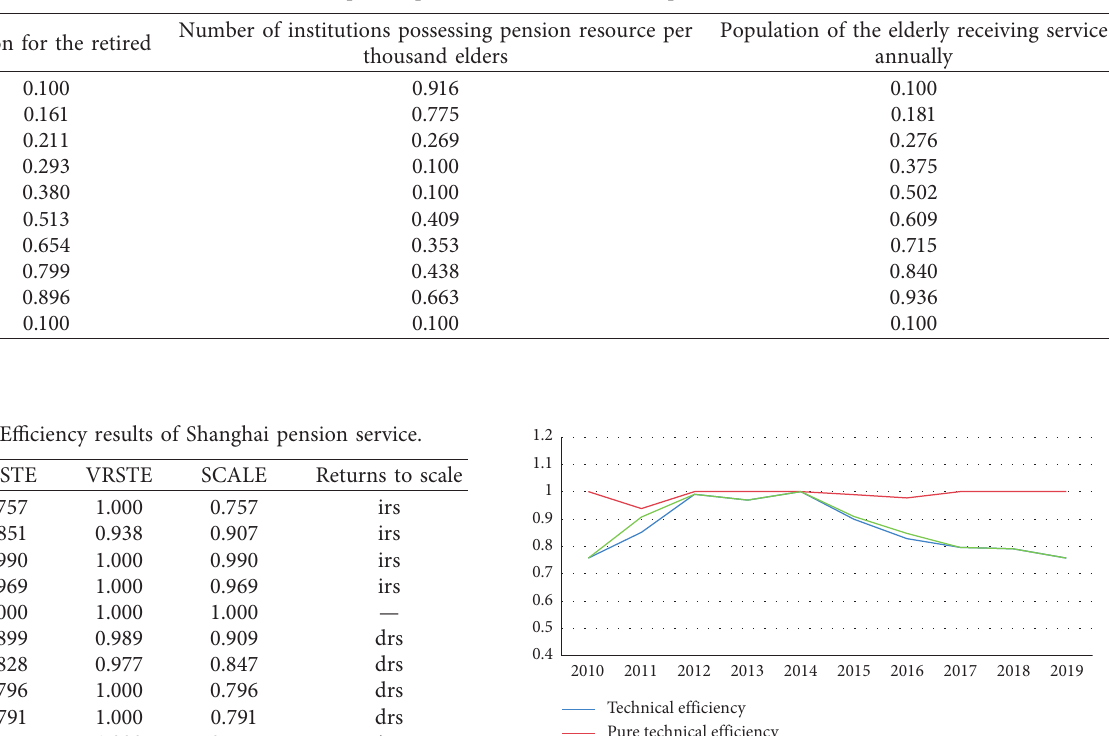
Table 2: Input-output data for dimensionless process.